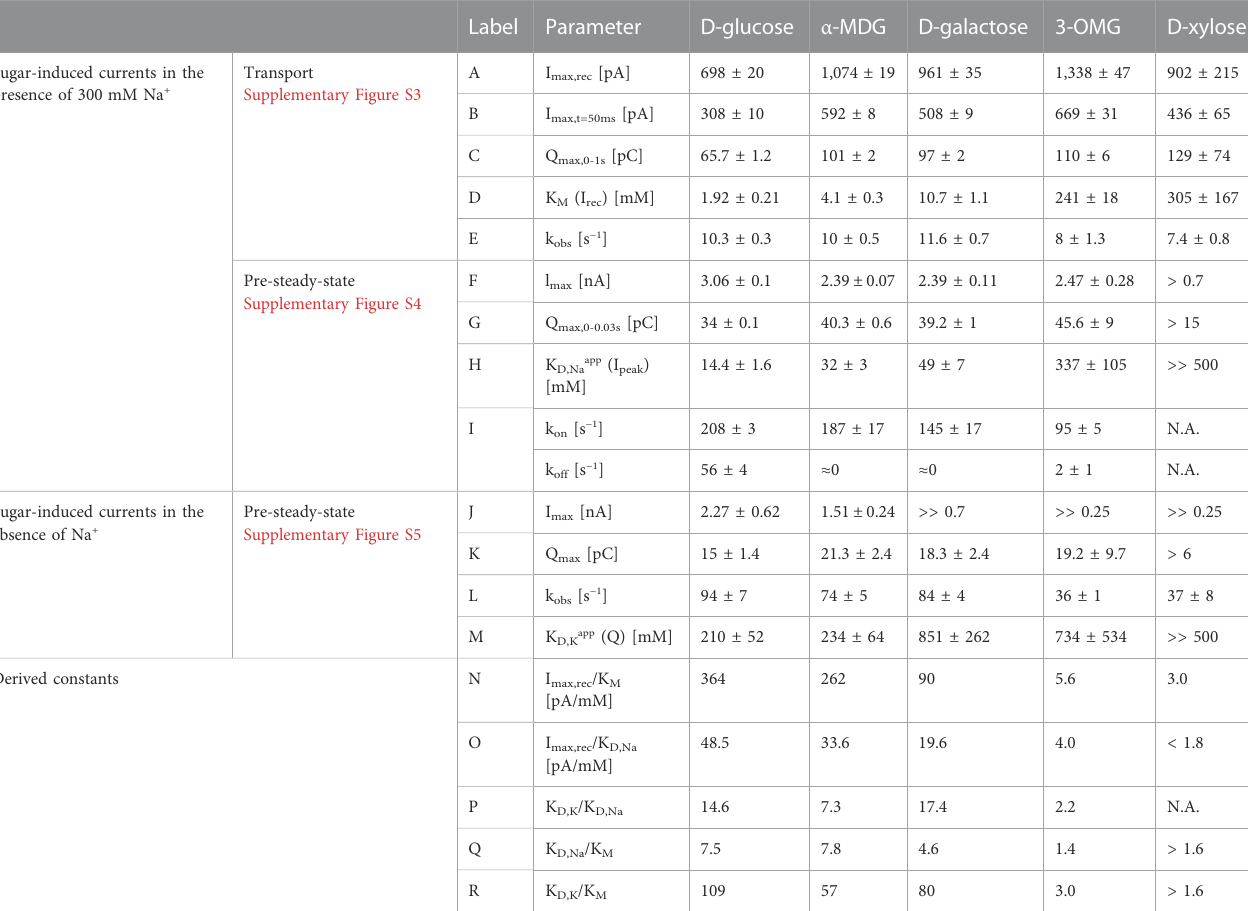
TABLE 1 Kinetic parameters obtained from transport and PSS currents using different sugar substrates in the presence and absence of Na + . Label